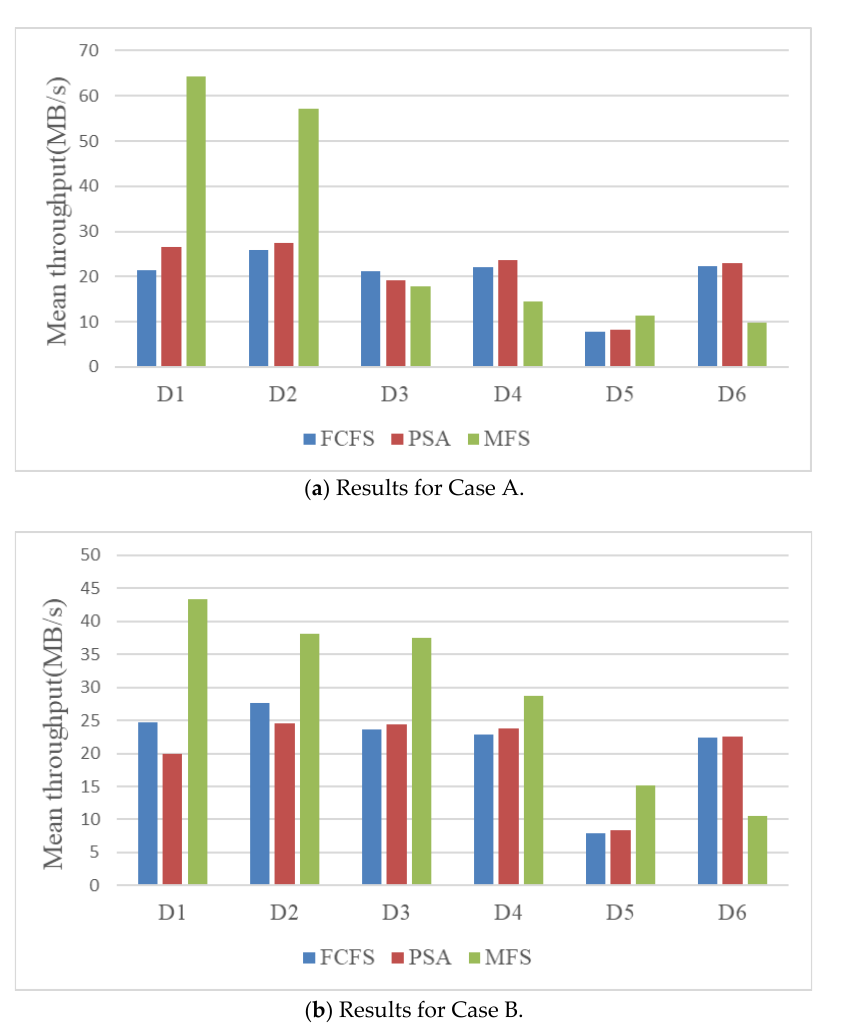
Figure 13. Mean throughput of come first serve (FCFS), priority scheduling algorithm (PSA) and the MFS method.